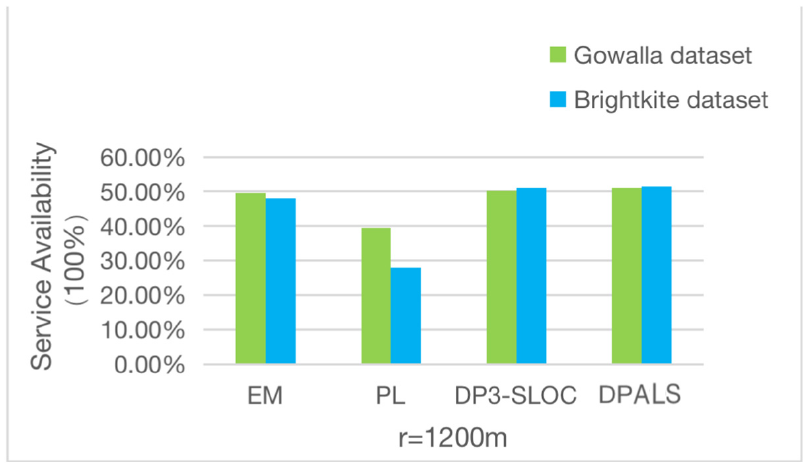
Figure 8. Service quality comparison for r = 1200 m.